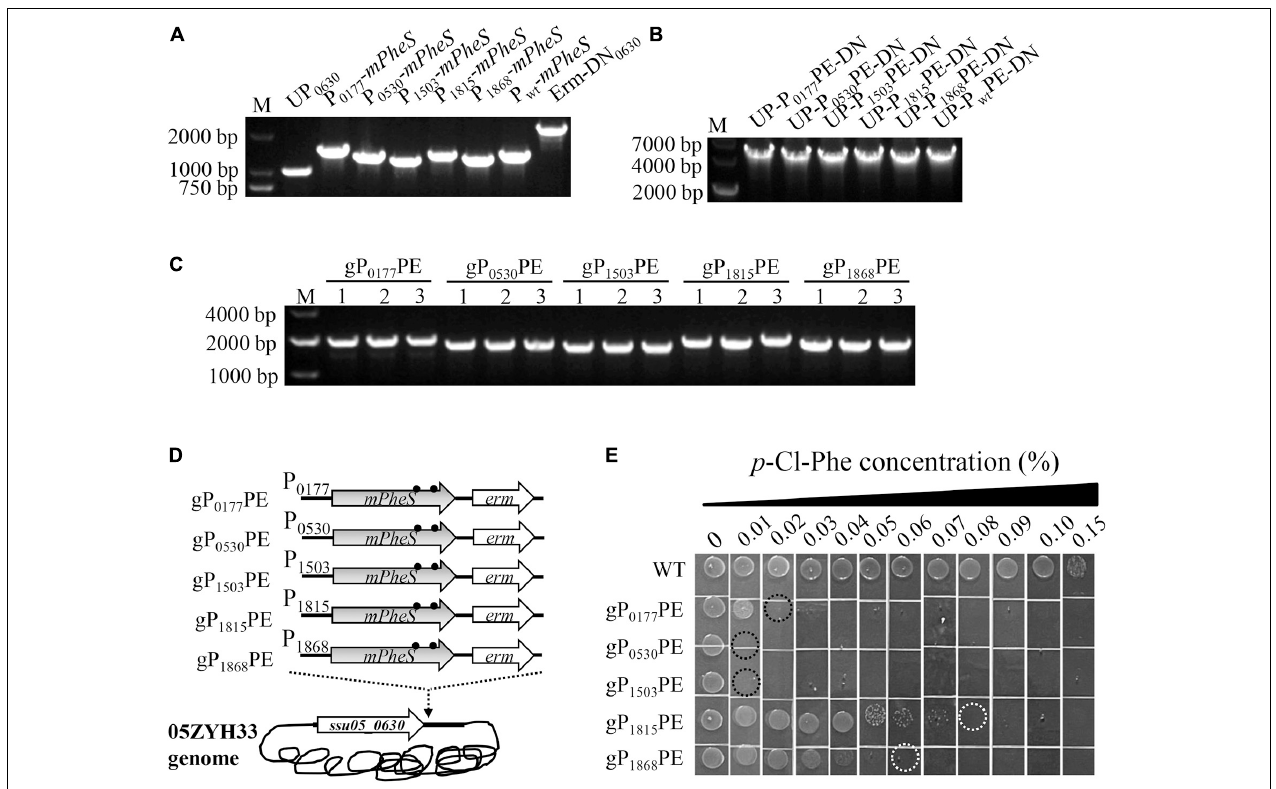
FIGURE 3 | Construction and growth inhibition test of S. suis strains with genome-integrated P- mPheS cassettes. (A) Amplification of UP 0630 , the six P- mPheS cassettes, and Erm-DN 0630 fragments. (B) Fused UP-PPE-DN fragments. (C) PCR confirmation of S. suis transformants with genome-integrated P- mPheS cassettes (gPPE) with primers SeqF/SeqR. (D) Diagram for the constructed S. suis with genome-integrated P- mPheS cassettes. (E) Growth inhibition of gPPE strains by the indicated concentrations of p -Cl-phe. The MIC for each strain was indicated with dashed cycle.